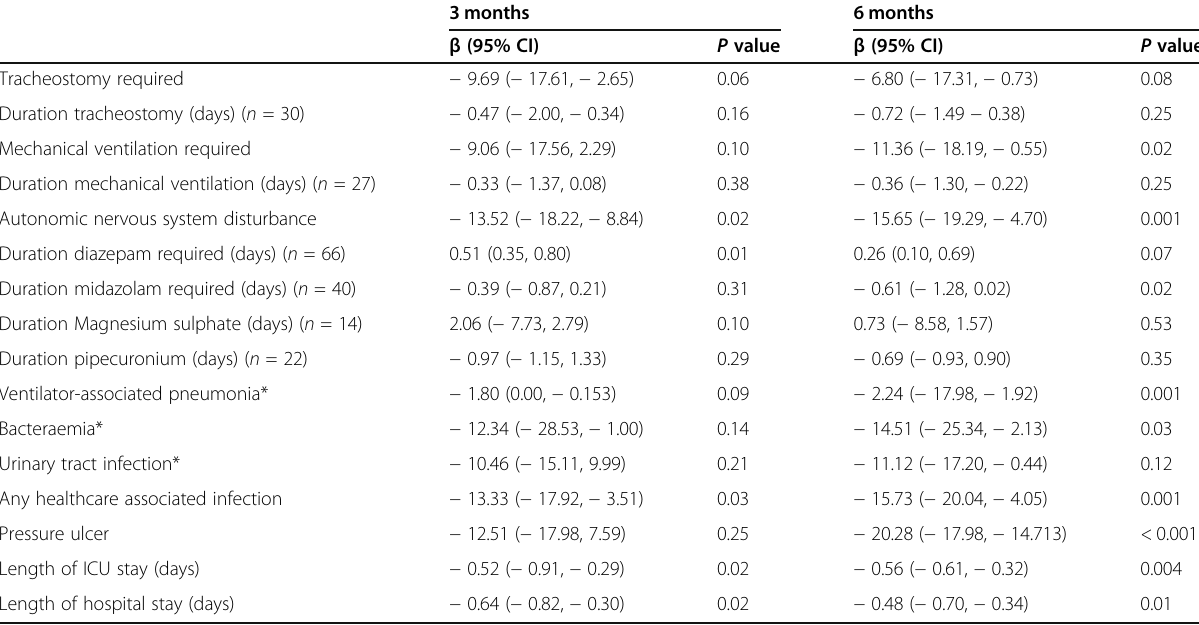
Table 5 The association between independent features during ICU management and 25th quantile PCS at 3 months and 6